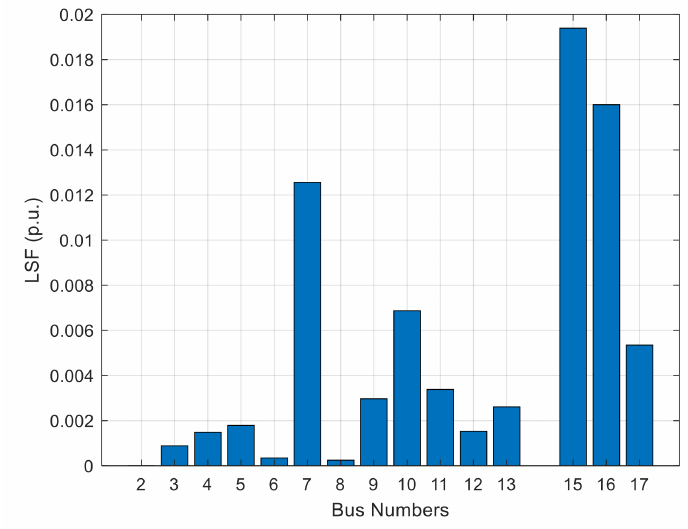
Figure 4. Loss sensitivity factor (LSF) values.